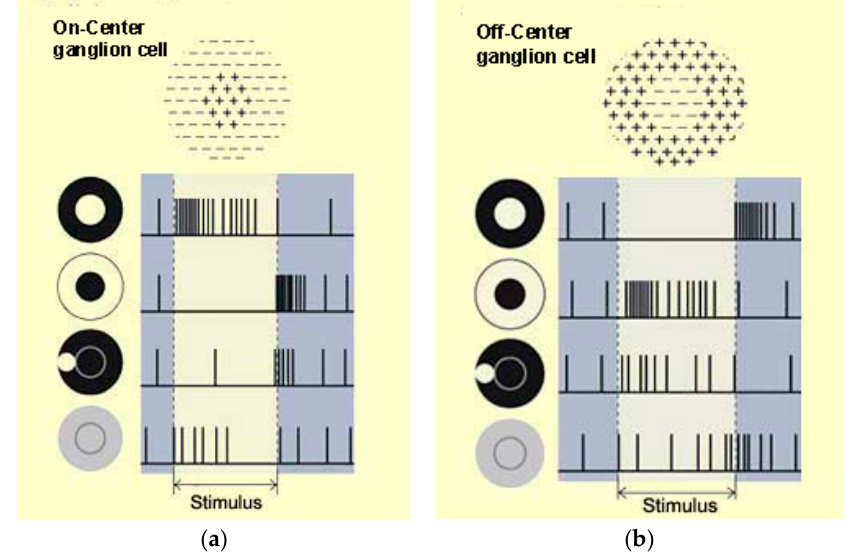
Figure 2. Receptive field in the retina. ( a ) on-center ganglion cell; ( b ) off-center ganglion cell.